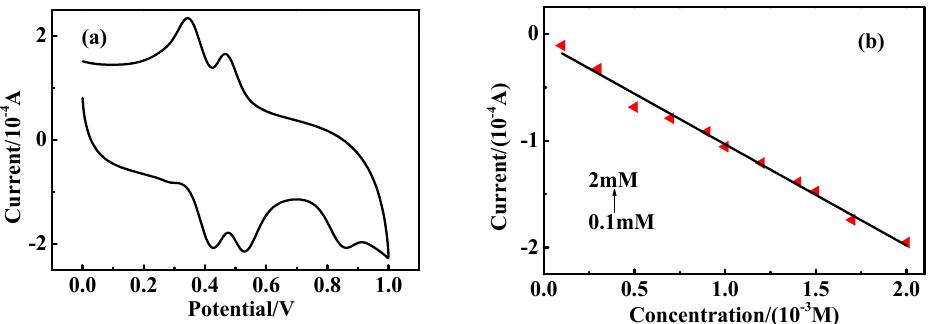
Figure 10. The electrocatalytic behavior of ZCF/GCE in the mixture solution of HQ, CC and RS ( a ) the current in the mixture solution of HQ, CC and RS; ( b ) the relation curve of reduction peak current and RS concentration.